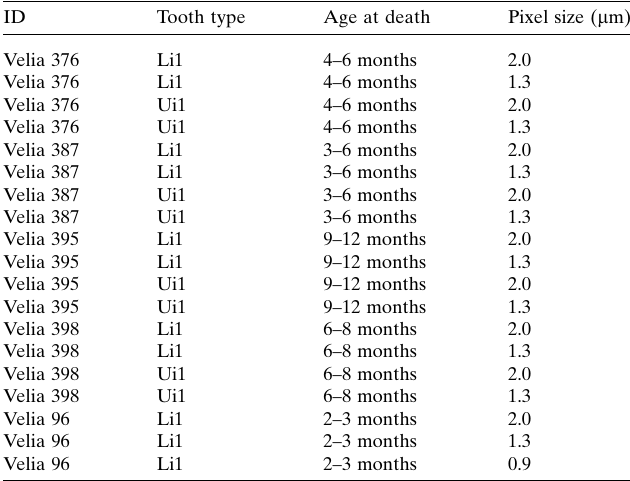
Table 1 Dental sample selected for SR m CT measurements. U = upper dental arch, L = lower dental arch, i1 = central deciduous incisor; age at death estimated by morphological assessment. Li1 = lower central deciduous incisor, Ui1 = upper central deciduous